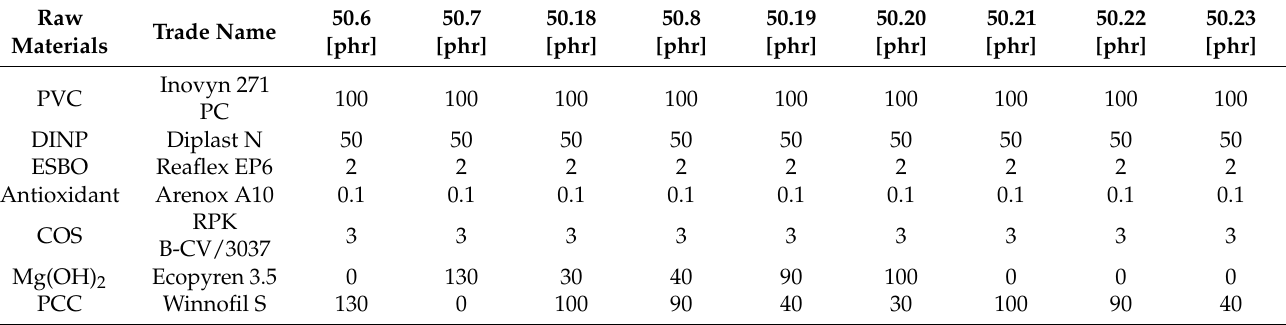
Table 3. Synergism of PCC/Mg(OH) 2 couple. The measures are performed according to